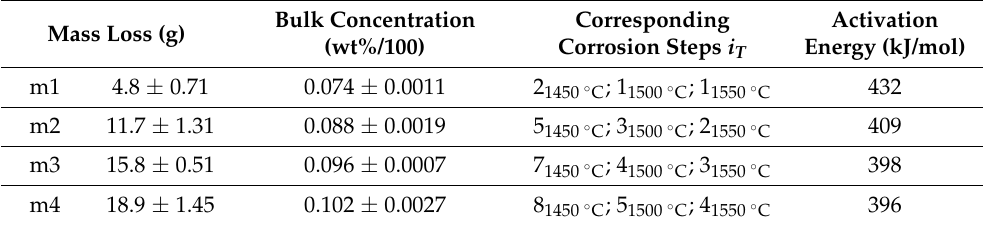
Table 3. Test intervals applied for the Arrhenius plot with the associated mass loss, bulk concentra- tions of magnesia, and the corresponding activation energies for magnesia.